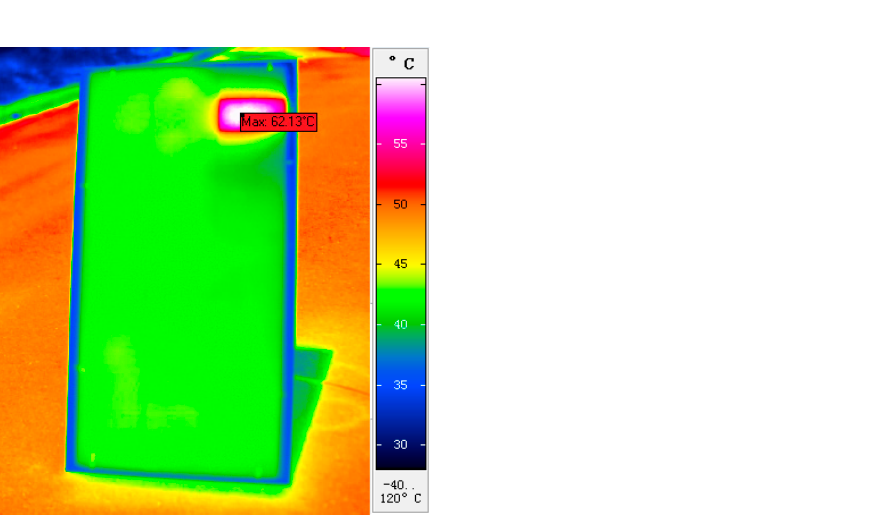
Figure 8. Infrared thermal image of photovoltaic panel with hot spot effect.